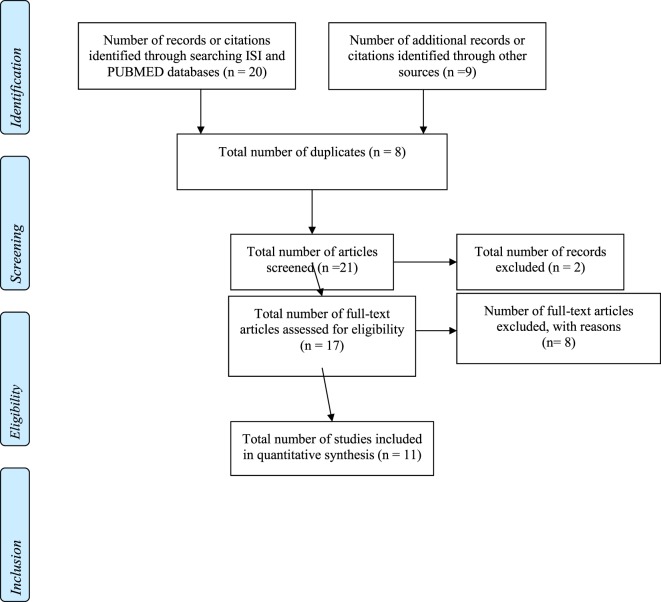
PRISMA flow diagram.